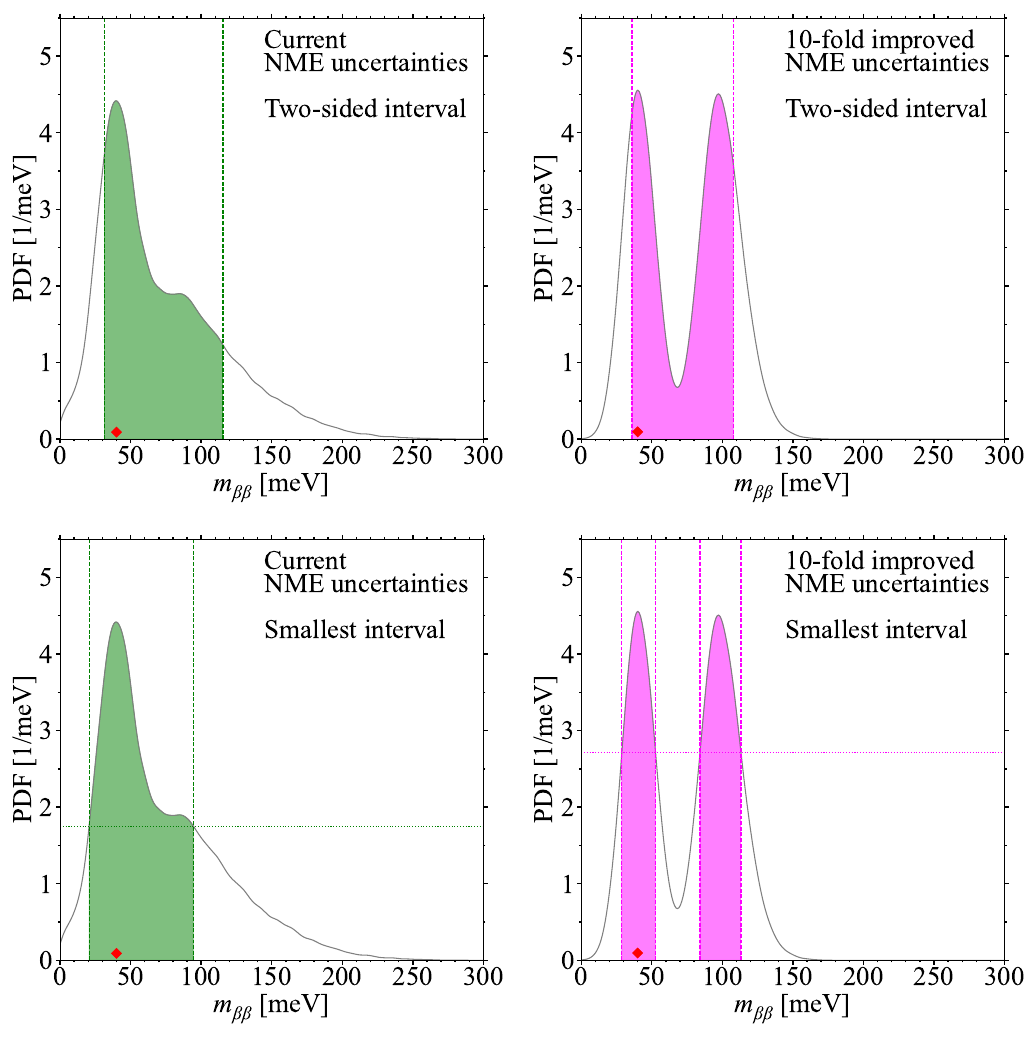
Figure 5 . Comparison between central (top) and smallest (bottom) credible intervals, for both current and reduced NME uncertainties for half-life values corresponding to m ββ = 40 meV, (cid:15) = 0 . Note that the smallest intervals correspond to those shown in the left panel of figure